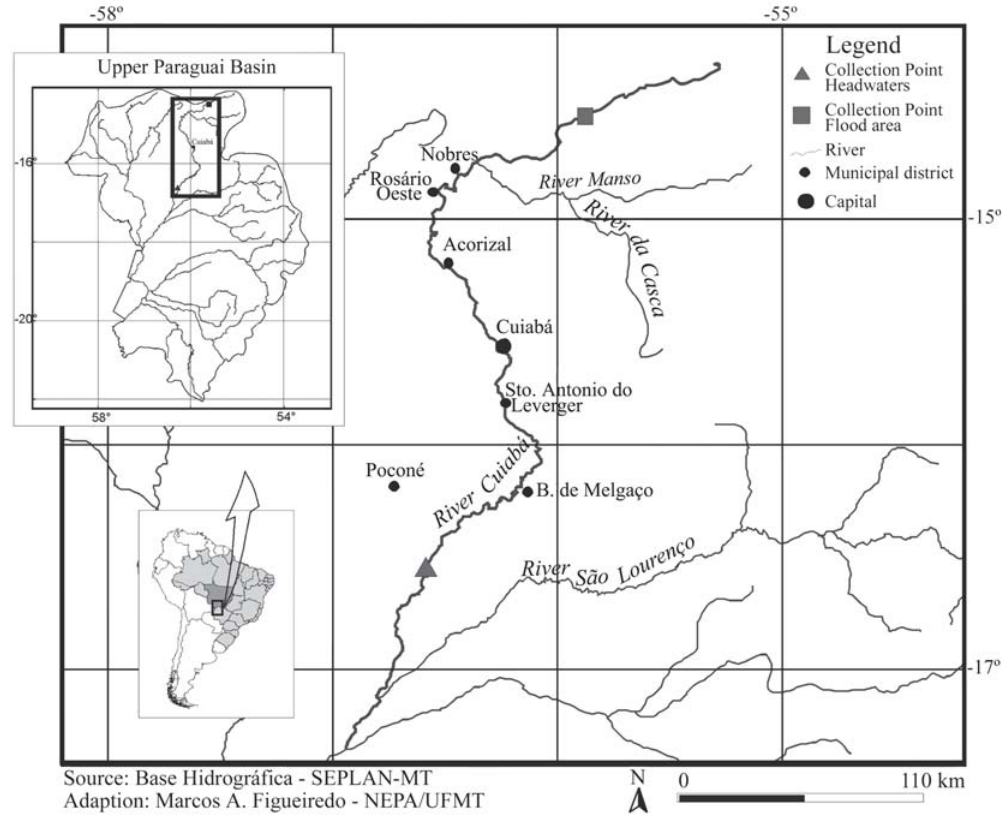
Fig. 1. Geographic location of the sites sampled in the Cuiabá River basin, Mato Grosso State,